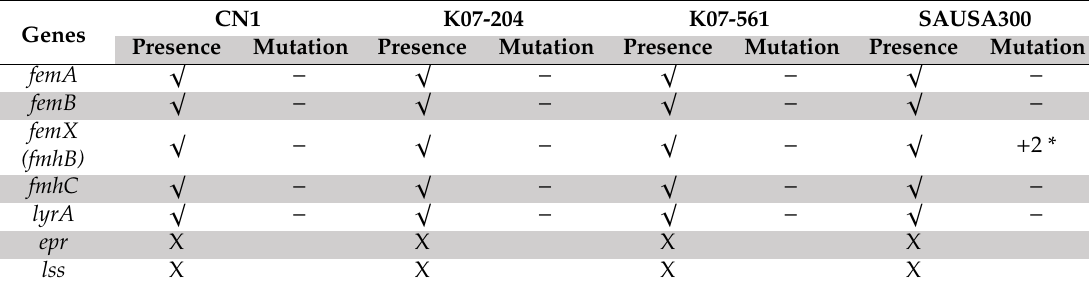
Table 1. Screening of existing mechanisms of lysostaphin